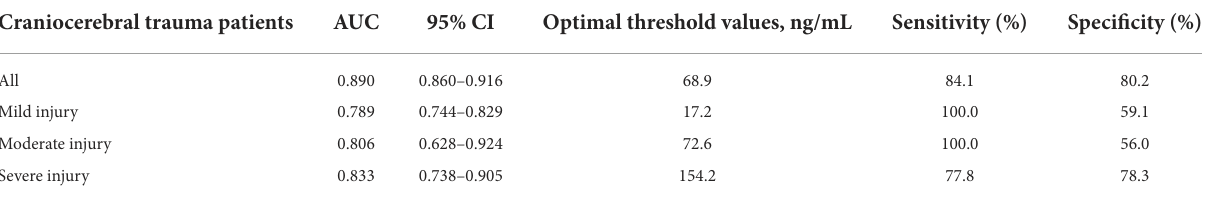
TABLE 3 Predictive efficiency of serum Cyclophilin A level for craniocerebral trauma patients’ prognosis. Craniocerebral trauma